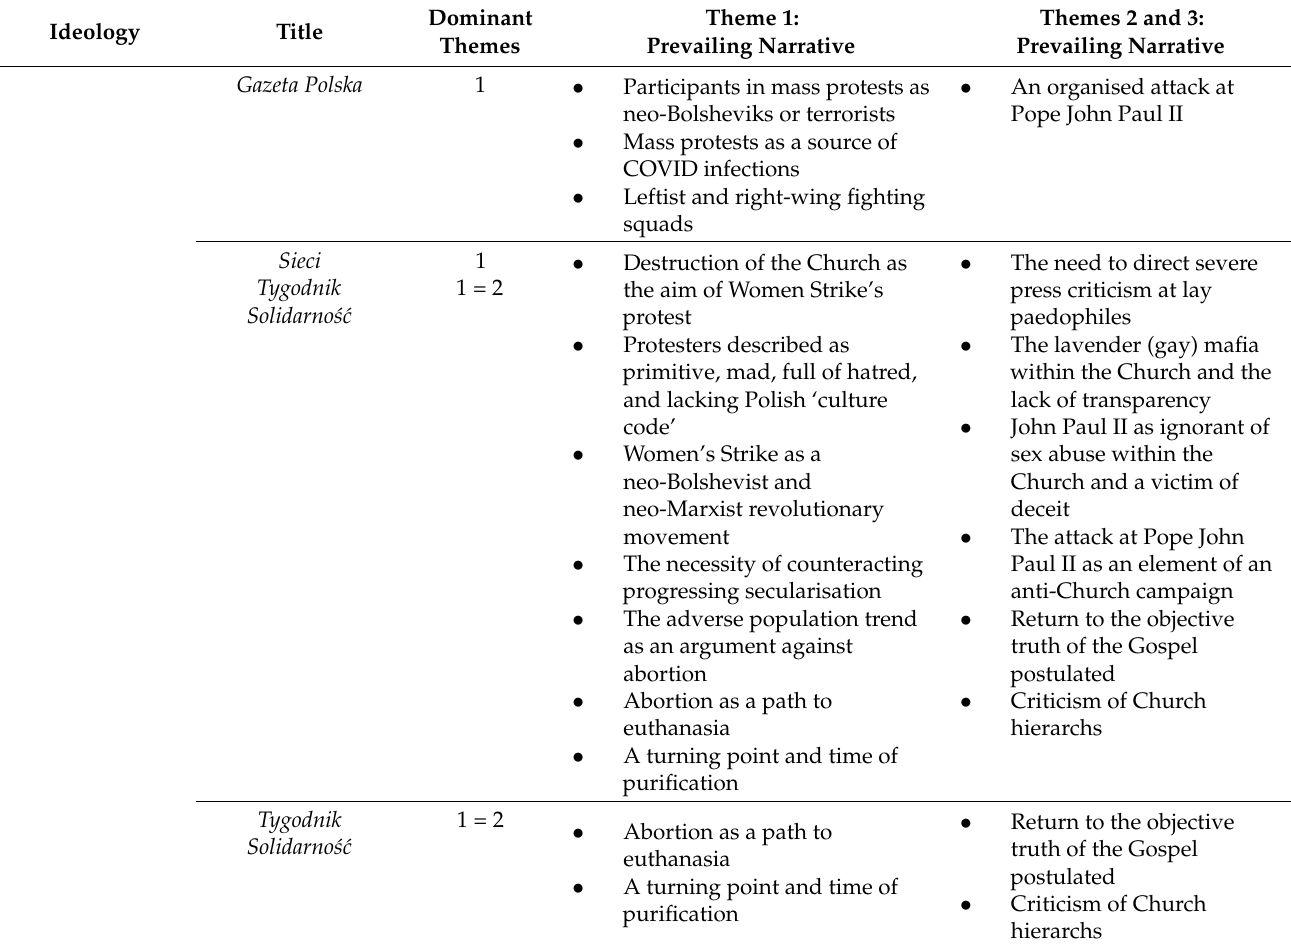
Table 4. Polish opinion-forming weeklies vis- à -vis the events associated with the crisis in the Catholic Church: The main issues and